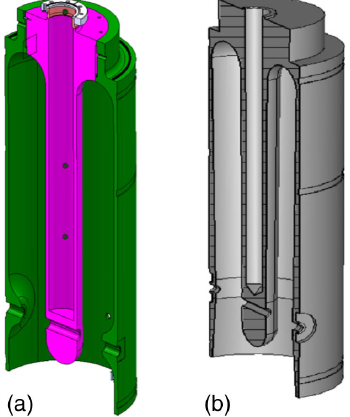
FIG. 1. Cross-section view of (a) the original substrate made of inner (magenta) and outer (green) pieces connected by electron- beam welding, and (b) the seamless substrate machined out of a copper